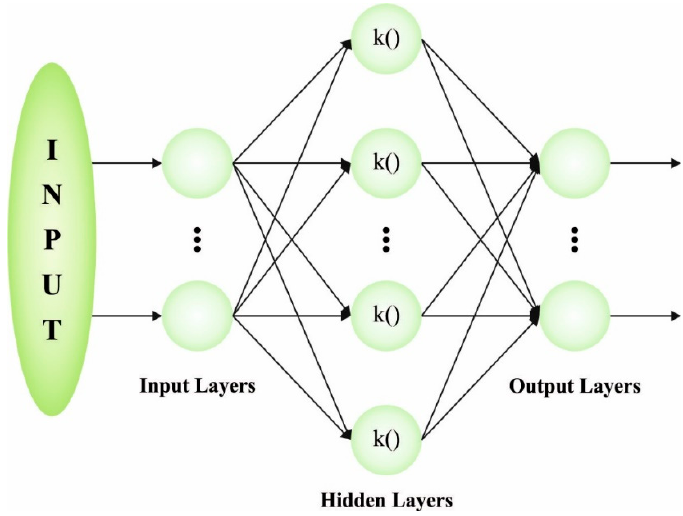
Figure 2. Architecture of ELM.